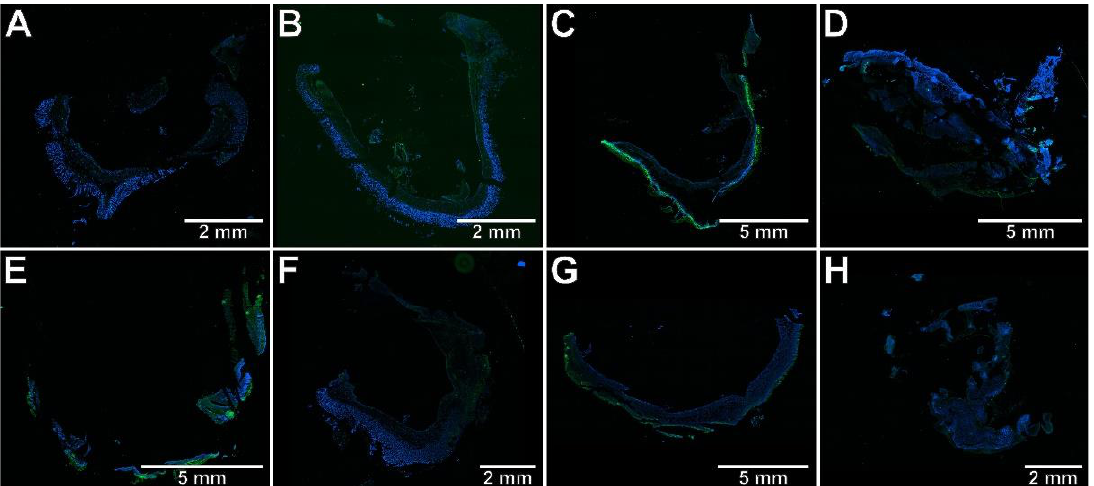
Figure 5. The photomicrographs of cryosections of the whole colon tissue samples after immunostaining with antibodies specific to STAT3 fluorescently detected demonstrated that compounds 7b and 13b counteracted TNBS-induced increase in STAT3 expression. Control group ( A ); group receiving only TNBS ( E ); group receiving 10 mg/kg compound 7b and TNBS ( B ); group receiving 20 mg/kg compound 7b and TNBS ( F ); group receiving 10 mg/kg compound 10b and TNBS ( C ); group receiving 20 mg/kg compound 10b and TNBS ( G ); group receiving 10 mg/kg compound 13b and TNBS ( D ); group receiving 20 mg/kg compound 13b and TNBS ( H ); magnification 4×.